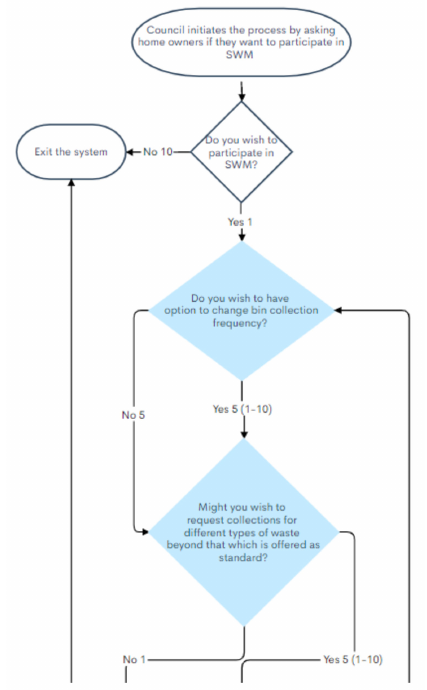
Figure 3. First phase of scoring a customer for SWM.